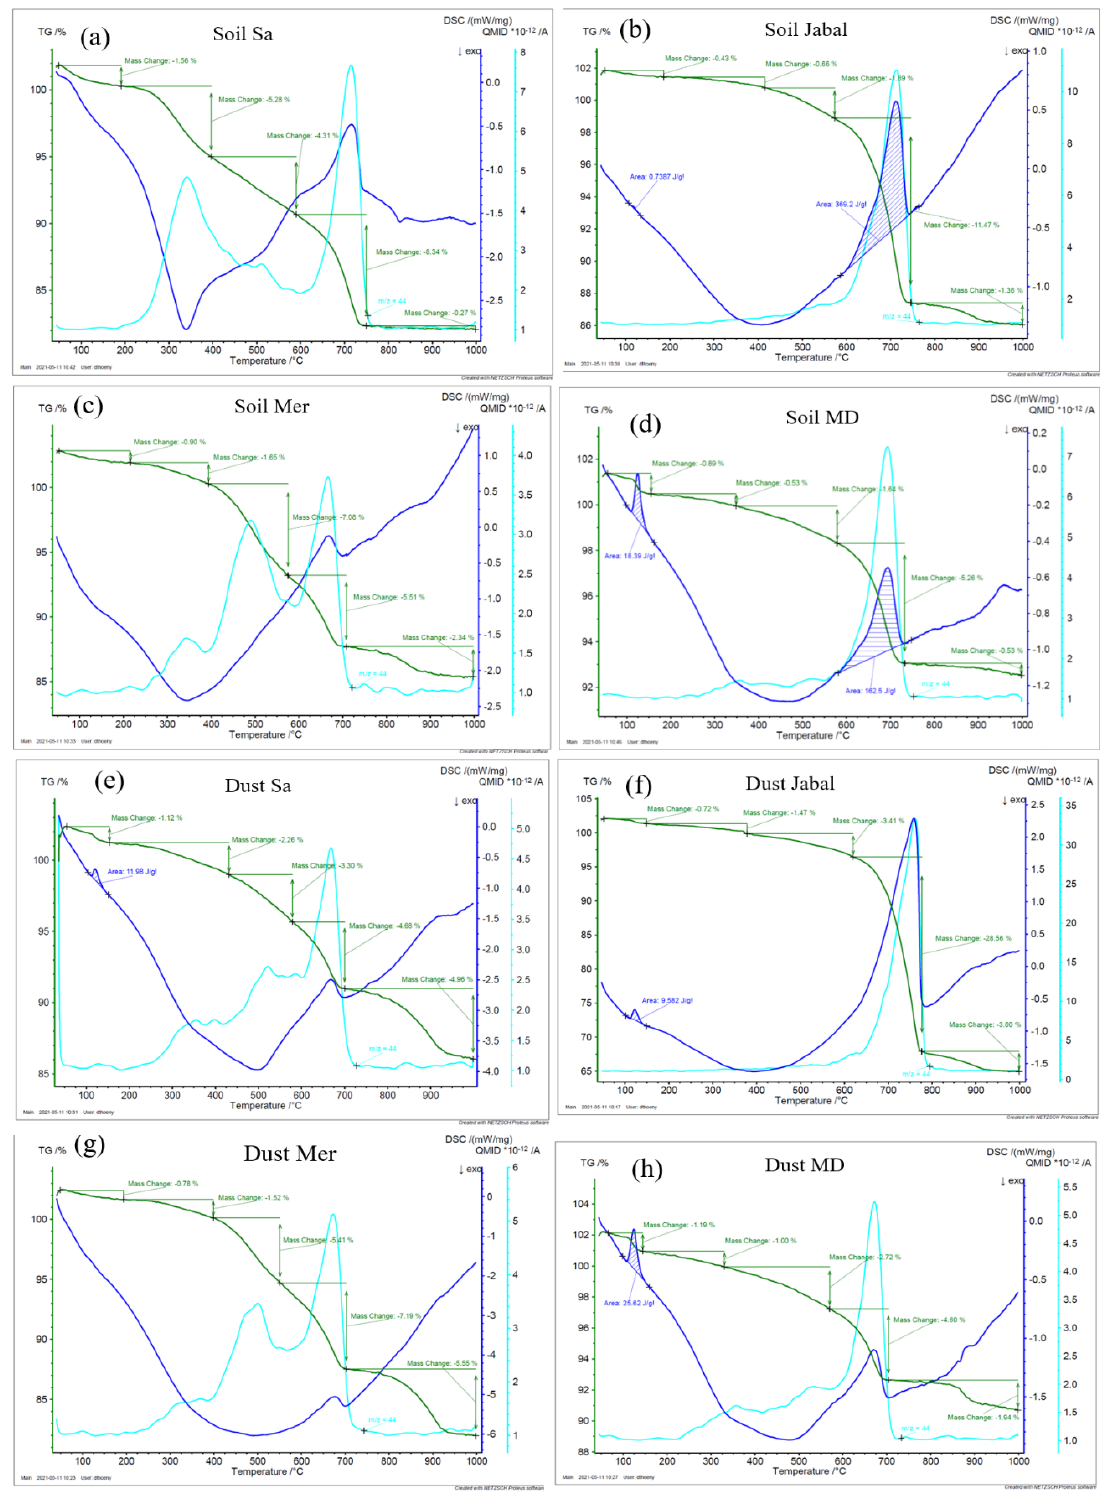
Figure A4. TG (green) and DSC (blue) curves of soil and dust samples with corresponding mass data plotted against temperature. Light blue: total ion current of mass 44 (CO 2